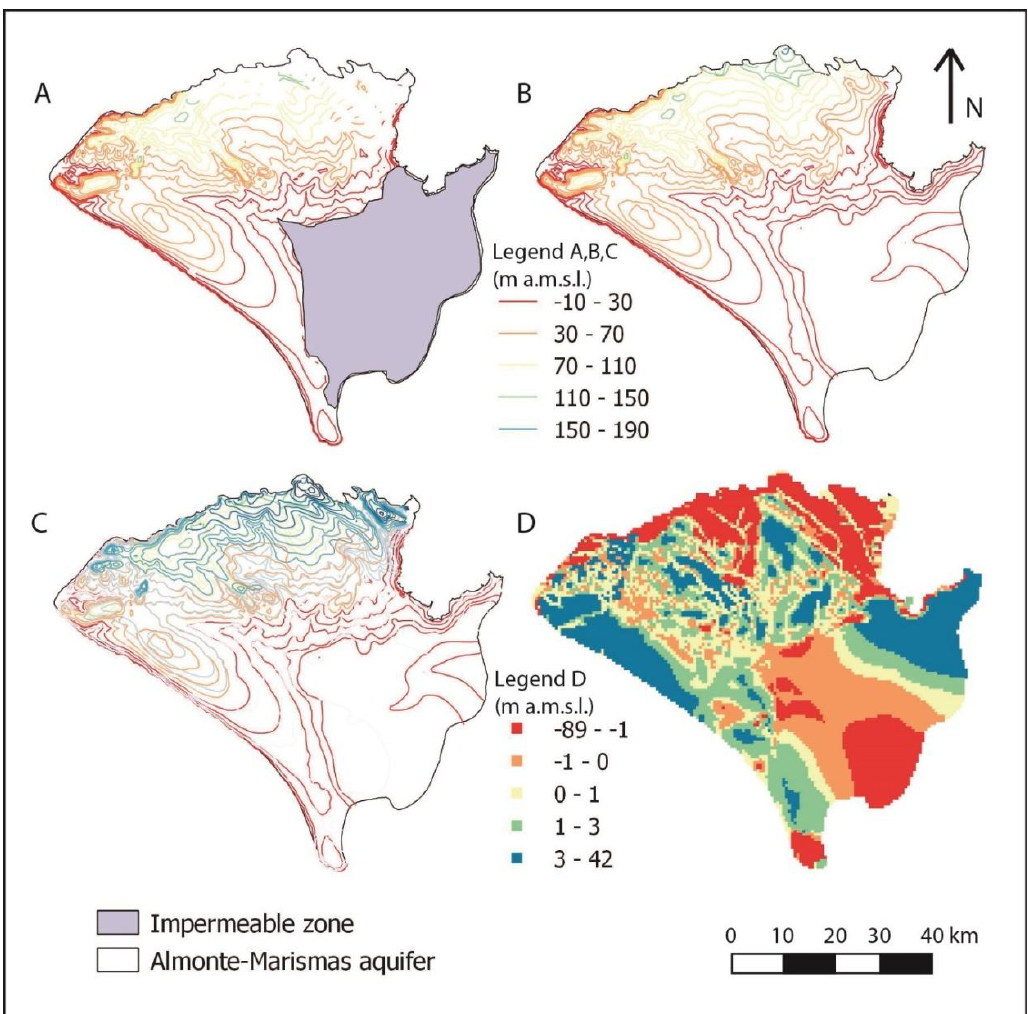
Figure 7. Piezometric contours of groundwater models: ( A ) first layer of the original model; ( B ) second layer of the original model; ( C ) model with hydrofacies simulation; ( D ) difference between ( B ) and ( C ).